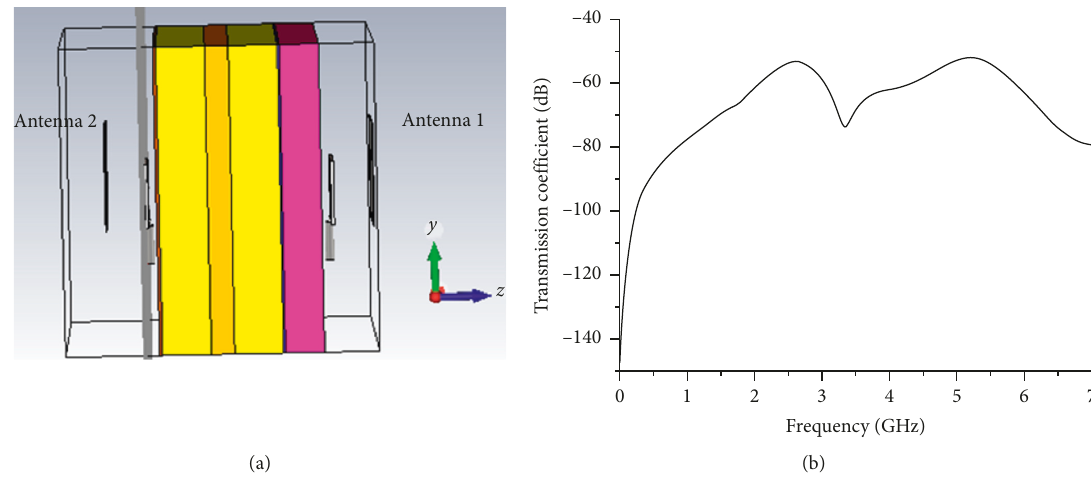
Figure 23: (a) The placement of two reflector-backed antennas on in-body communications. (b) Transmission coefficient for in-body scenario attempt.